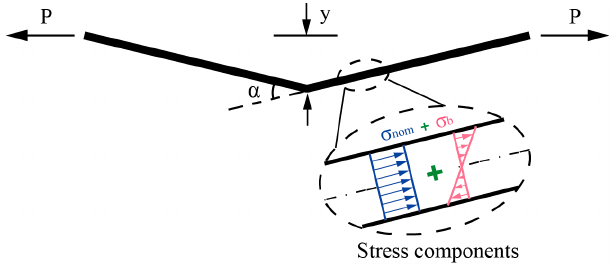
( b ) Figure 10. Comparisons of the SCF ( K t ) determined by FEM and parametric formulae: ( a ) training data system; ( b ) test data system. 4. Elastic SCF and Clamping Stress Formulae for Distorted Butt-Welded Joints 4.1. Definition of K m,test and K act Section 3 has addressed the SCF for undistorted butt-welded joints, and the influence of the angular distortion on the SCF will be discussed in this section. As mentioned earlier, the fatigue performance of welded joints can be significantly influenced by the angular distortion which